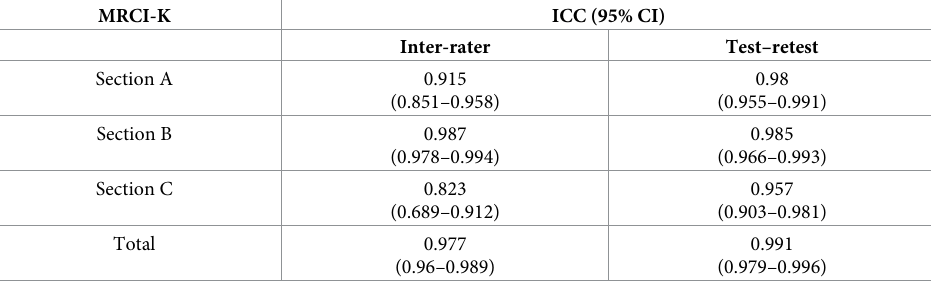
Table 2. Inter-rater and test–retest reliability of MRCI-K.